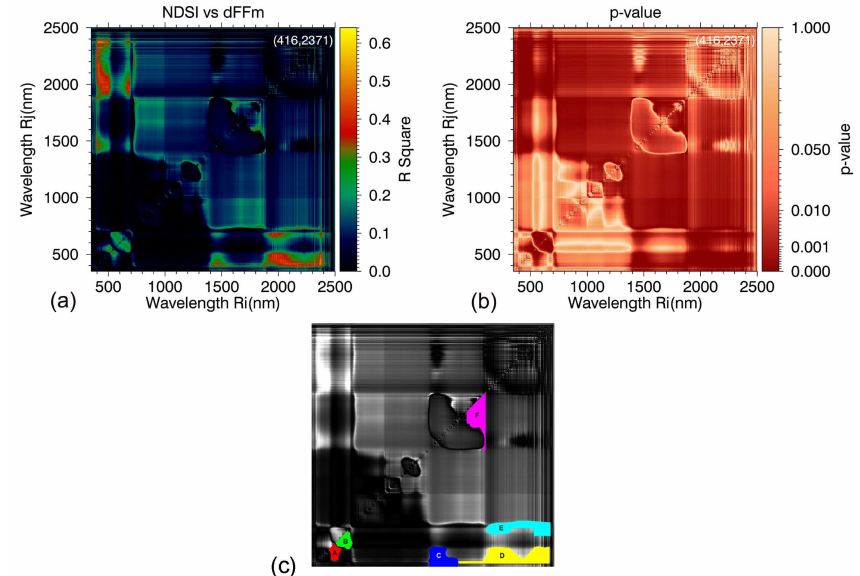
Figure 6. Coefficient of determination ( R 2 ) ( a ) and corresponding p -values ( b ) between the fluorescence yield ( ∆ F/Fm’ ) and NDSI (R i ,R j ). ( c ) shows regions of interests that have large R 2 and high significance.